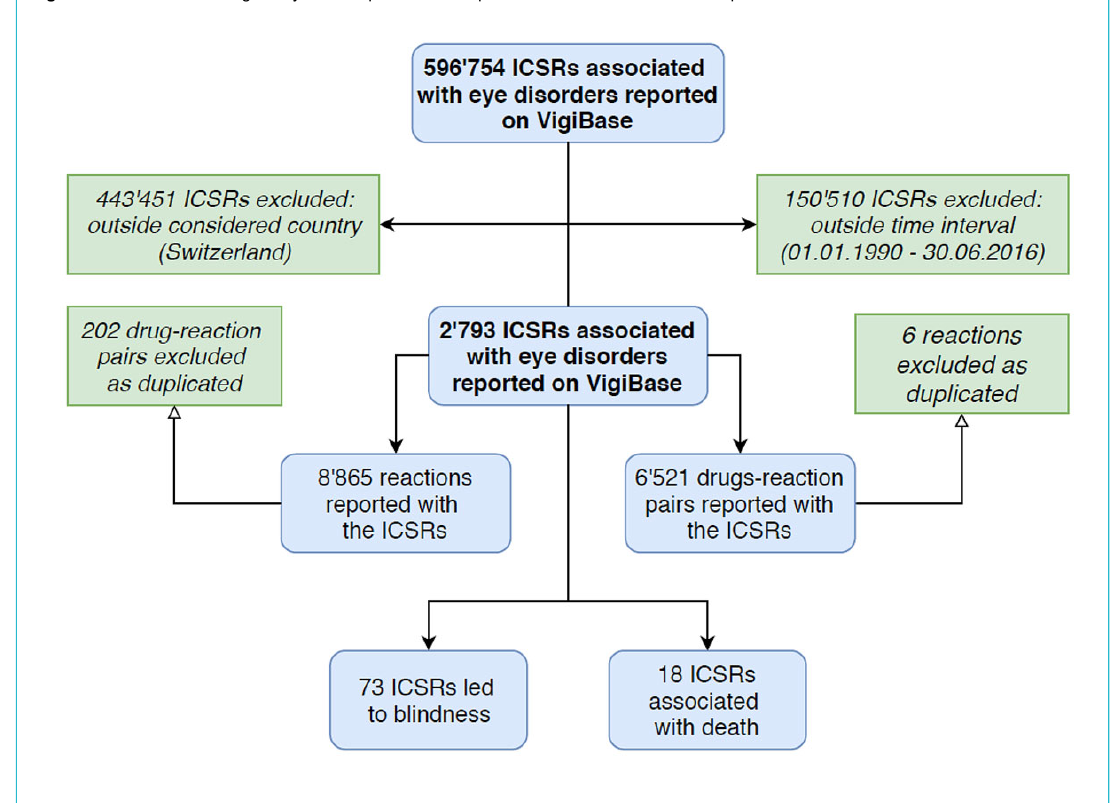
Figure 1: Flow chart showing the systematic processes adopted to achieve the final data